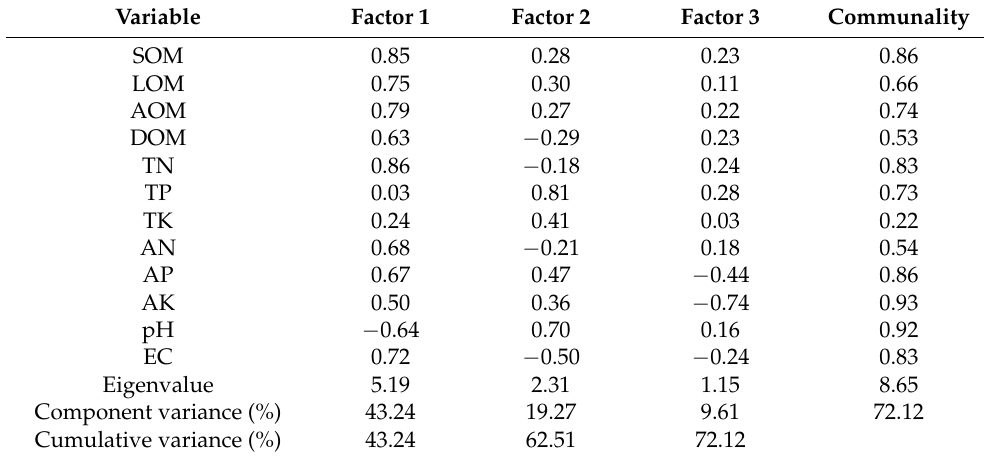
Table 2. Variable loading coefficients of the first three factors extracted using soil properties and communality in 2021.